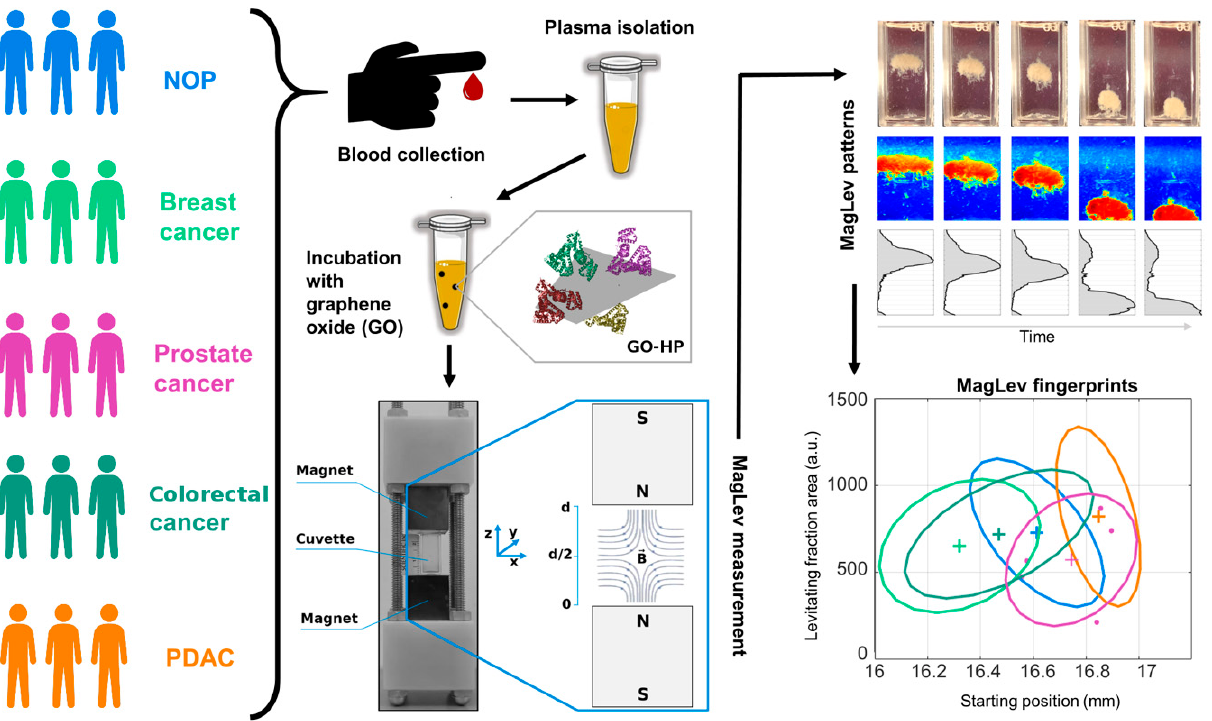
Figure 4. Workflow of the MagLev nanoparticle-enabled blood (NEB) test for cancer detection. Blood from non-oncological patients (NOP) and patients affected by different cancer types is collected. Then human plasma is separated and incubated with NPs such as graphene oxide (GO). NP-HP complexes are injected into a cuvette filled with a paramagnetic medium and inserted into a MagLev device. Levitation patterns are acquired and processed to quantify MagLev profiles. Lastly, fingerprints such as the levitating fraction area and the starting position of the levitating fractions are detected. Reprinted from Quagliarini et al., Nanomaterials 2022, 12, 1397 [18].